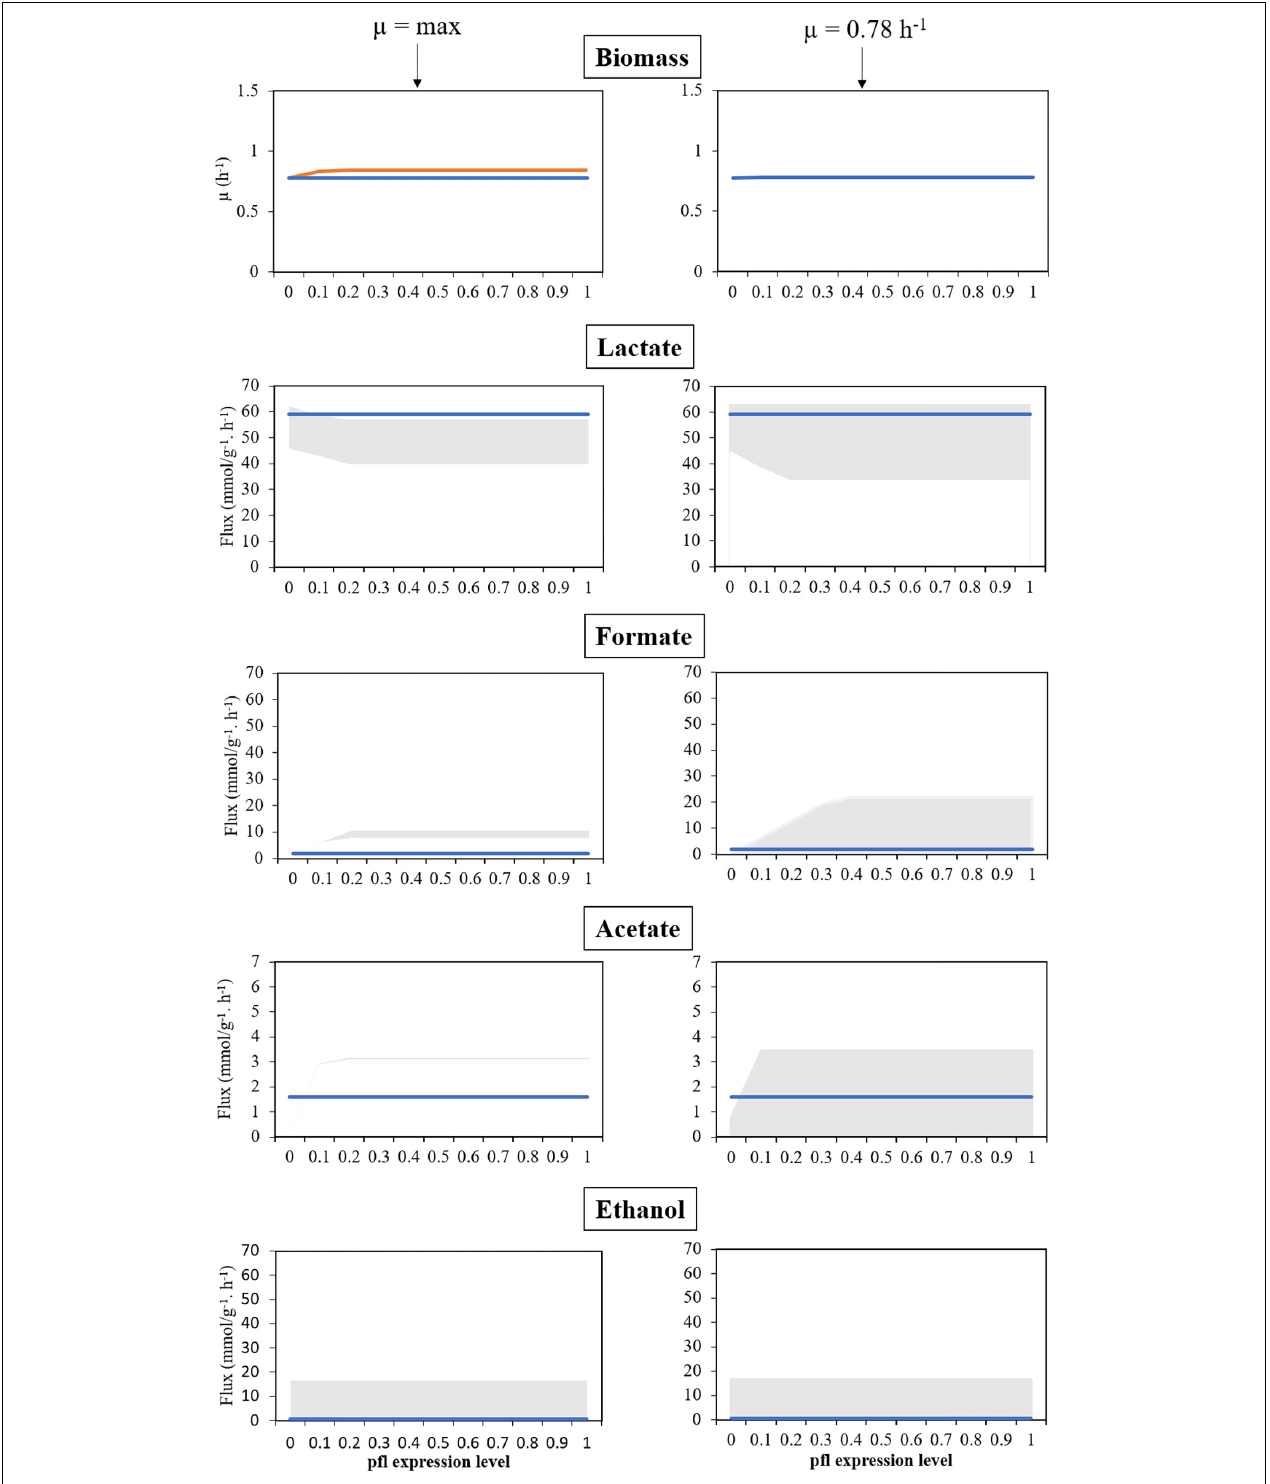
FIGURE 3 | Model assessment in anaerobic conditions, for several levels of expression of the pfl genes, in silico , against experimental data. Left panel corresponds to a maximization of growth rate as objective function. Right panel corresponds to simulations with fixed maximum growth rate ( µ = 0.78 h − 1 ). Blue lines represent experimental data, the orange line represents the maximization of the specific growth rate, and the shadowed areas represent the products’ flux variability analysis. All simulations were performed with environmental conditions inferred from Carvalho et al. (2013).